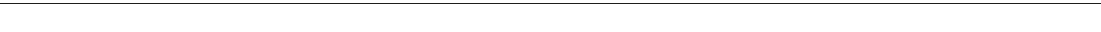
Fig. 4 IL-6R α de fi ciency compromises CCR-6-expressing lymphocyte recruitment in CAC. a IPA analysis diagram of quantity of downregulated (green) and upregulated (red) lymphocyte-speci fi c genes in tumours derived from 17-week-old HFD-fed Il6r α Fl versus Il6r α KO mice at day 62 of the 1.5% AOM/DSS protocol. Upper number represent respective p -value, lower number fold change. b qPCR analysis of indicated gene expression in tumours of 17-week-old Il6r α Fl versus Il6r α KO ( n = 6 – 12) mice at day 62 after the 1.5% AOM/DSS protocol, results are presented relative to NCD Il6r α Fl non-colitic colons. Representative immuno fl uorescent stainings of c FoxP3 (red), d γδ TCR (red) and e IgM ( green ) expressing cells in colons from 17-week-old HFD-fed Il6r α Fl and Il6r α KO mice at day 62 of the 1.5% AOM/DSS protocol counterstained with Hoechst 3342. f Total number of CD45 + , F4/80 + and F4/80 − cells isolated from non-colitic and colitic colons at day 0 or day 13 of the 1.5% AOM/DSS protocol in 8- and 10-week-old NCD-fed Il6r α Fl ( n = 4 – 5) versus Il6r α KO ( n = 4) mice. g Total number of CD19 + , γδ TCR + and β TCR + cells isolated from non-colitic and colitic colons at day 0 or day 13 of the 1.5% AOM/ DSS protocol in 8 and 10-week-old NCD-fed Il6r α Fl ( n = 4 – 5) versus Il6r α KO ( n = 4) mice. h Total number of CD19 + CCR-6 + , γδ TCR + CCR-6 + and β TCR + CCR-6 + cell isolated from non-colitic and colitic colons at day 0 or day 13 of the 1.5% AOM/DSS protocol in 8- and 10-week-old NCD fed Il6r α Fl ( n = 4 – 5) versus Il6r α KO ( n = 4) mice. AOM, azoxymethane; DSS, dextran sodium sulphate; NCD, normal chow diet; HFD, high-fat diet; IPA, Ingenuity pathway analysis; CAC, colitis-associated colorectal cancer. Centre line: median; box limits: 1st and 3rd quartiles; whisker: maximum to minimum, * p ≤ 0.05, ** p ≤ 0.01 and *** p ≤ 0.001 two-tailed unpaired Student ’ s t -test b , one-way ANOVA followed by Fisher LSD f – h . Scale bar, 100 μ m c , e , 200 μ m